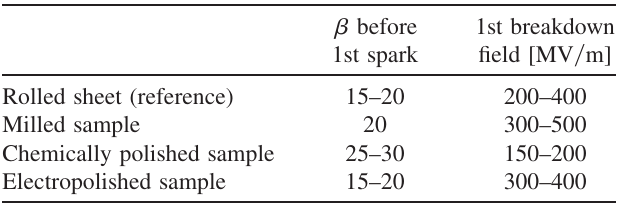
TABLE I. Effects of surface treatments on Cu samples.